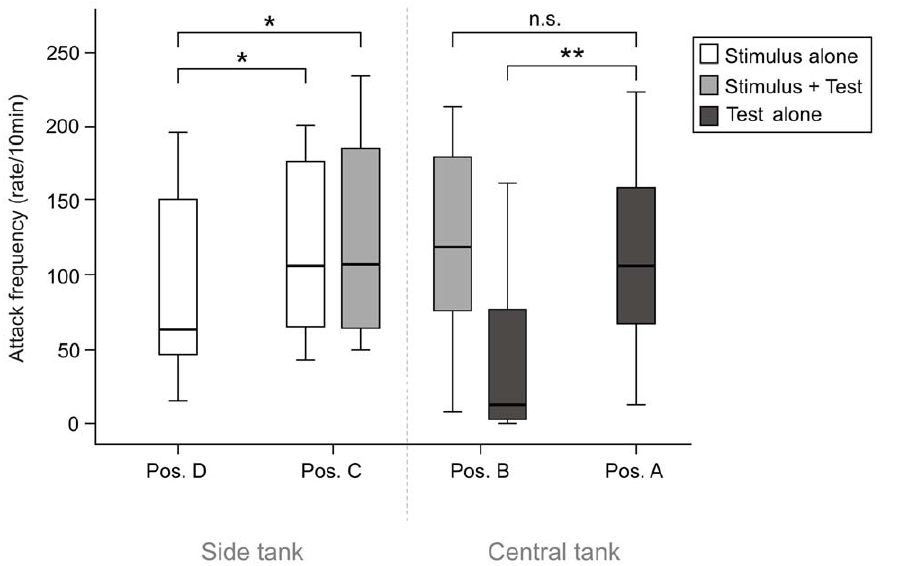
Figure 2. Anti-predator attack rates by test and stimulus pairs at their neighbor and non-neighbor positions. Test pairs decreased their attack rates next to their neighbor. Stimulus pairs increased their attack rates next to the neighbor. Position A: predator presentation on the non- neighbor side of the test pair; Position B: intruder presentation on the neighbor side of the test pair; Position C: intruder presentation on the neighbor side of the stimulus pair; Position D: intruder presentation on the non-neighbor side of the stimulus pair. *P , 0.05, **P , 0.001. In dark grey the attack rate of the test pair; in light grey the combined attack rate of both pairs; in white the attack rate of the stimulus pair.